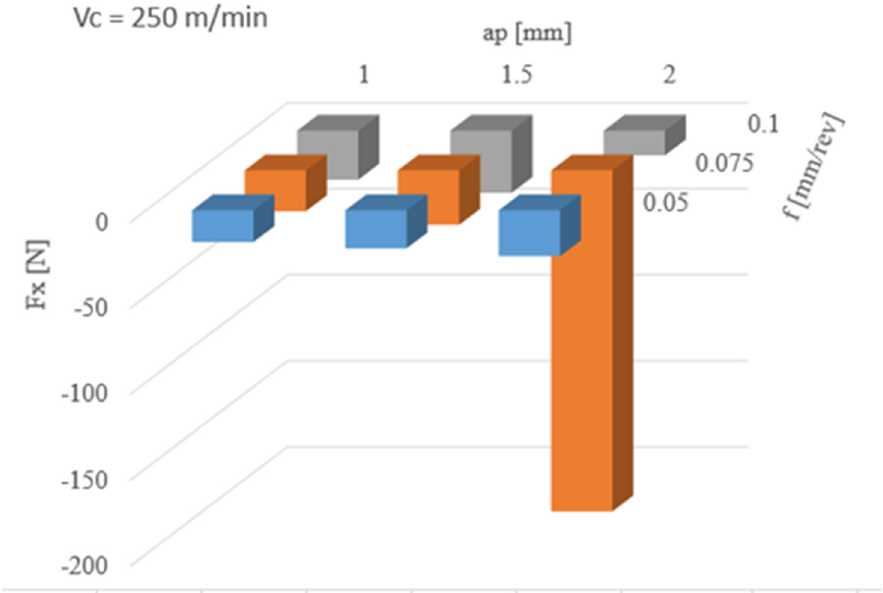
Figure 9. The results of changing cutting parameters on Fx.